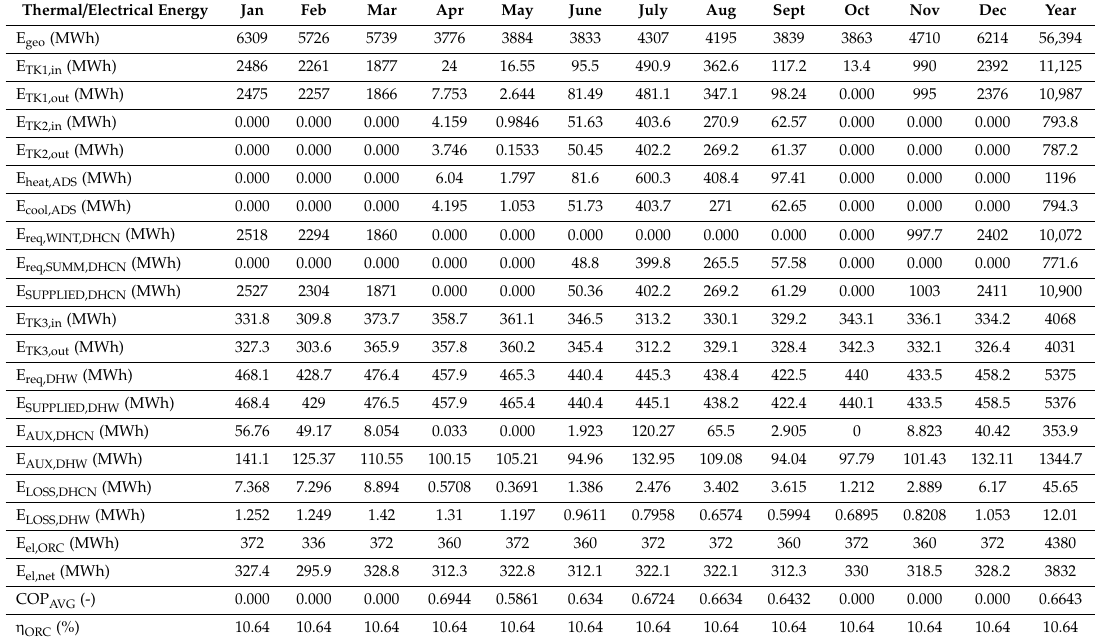
Table A5. Main results of the thermodynamic analysis (stop time of the DHCN at